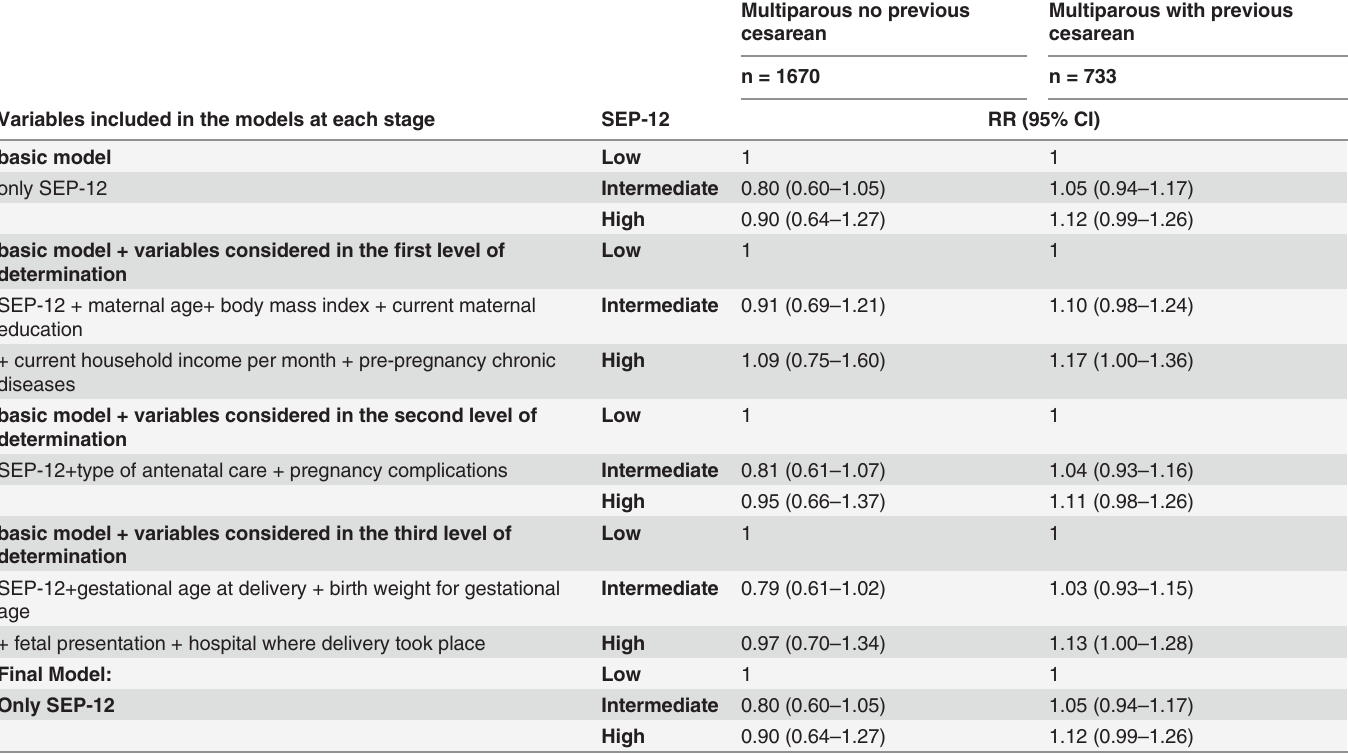
Table 6. Risk ratio for cesarean delivery by SEP-12 among multiparous women with only a previous delivery (n =